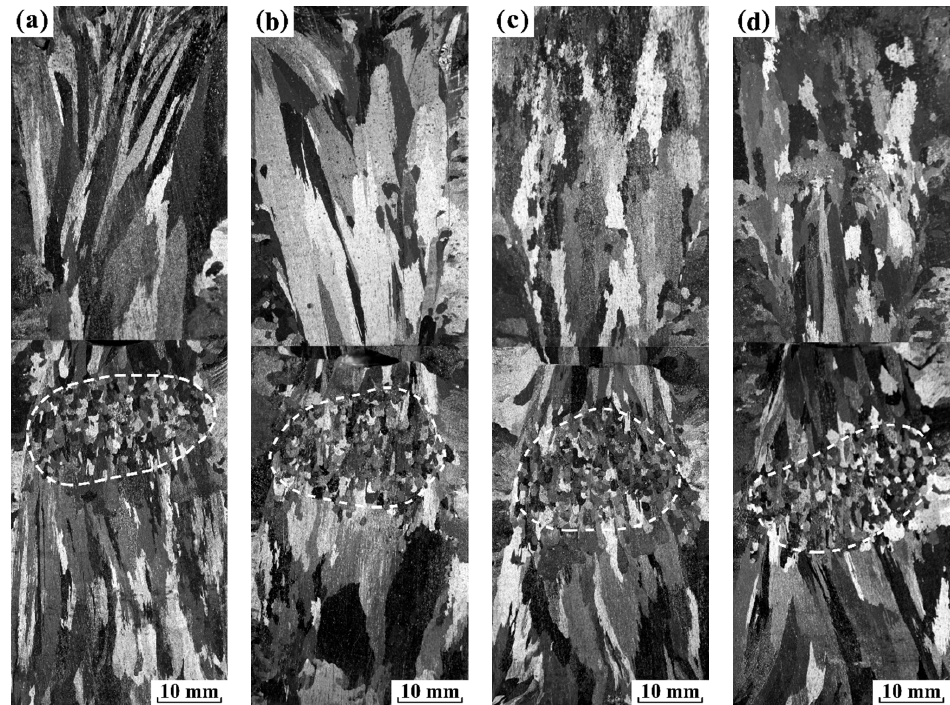
Figure 3. Longitudinal sections of the solidification structure in pure aluminum ingots under electropulsing with 480 A at different temperatures of mold: ( a ) room temperature; ( b ) 373 K; ( c ) 473 K and ( d ) 573 K.